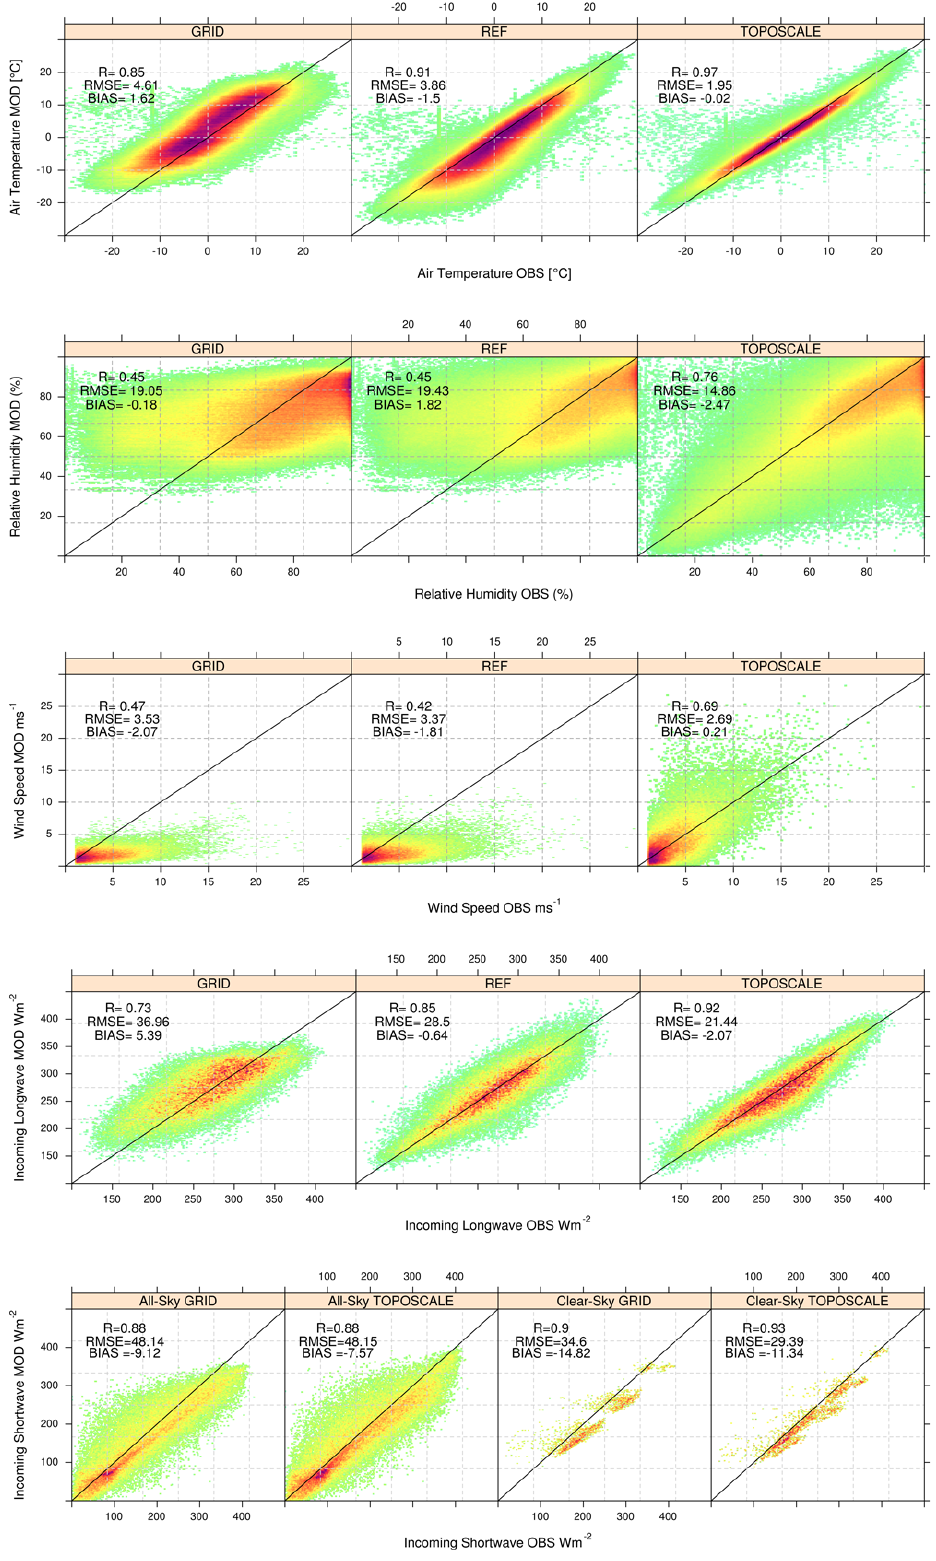
Fig. 5. Observed mean daily versus modelled T , Rh, Ws and LWin for GRID, REF, and TopoSCALE methods. The representation is a smoothed density plot to allow visualisation of large number plot points (IMIS-Data © 2013, SLF).